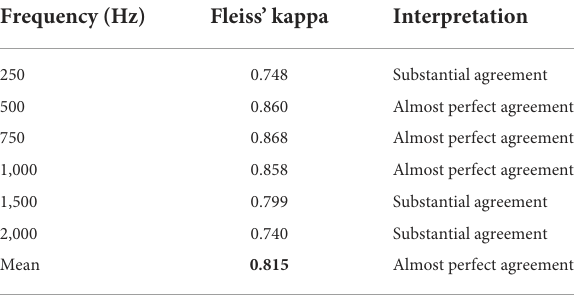
TABLE 3 Fleiss’ kappa among all three examiners.